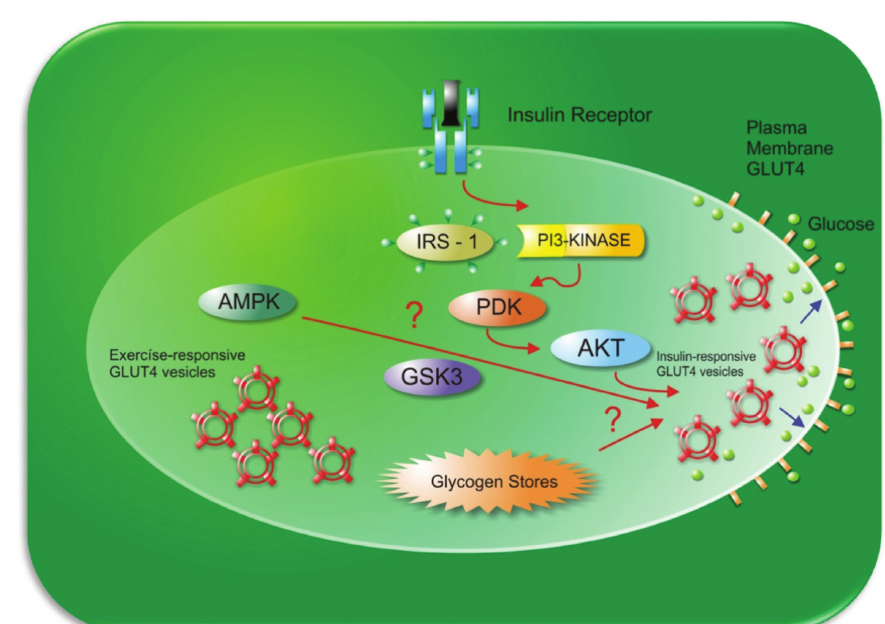
FIGURE 2 - Post-exercise mechanisms evolving insulin sensitivity (Hayashi, Wojtaszewski, Goodyear, 1997; Zierath, 2002; Wojtaszewski et al. ,